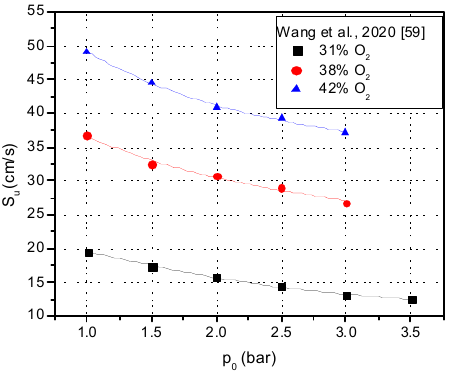
Figure 22. Initial pressure influence on experimental laminar burning velocity for stoichiometric biogas-air-oxygen mixtures. Data refers to various oxygen contents and 298 K initial temperature.